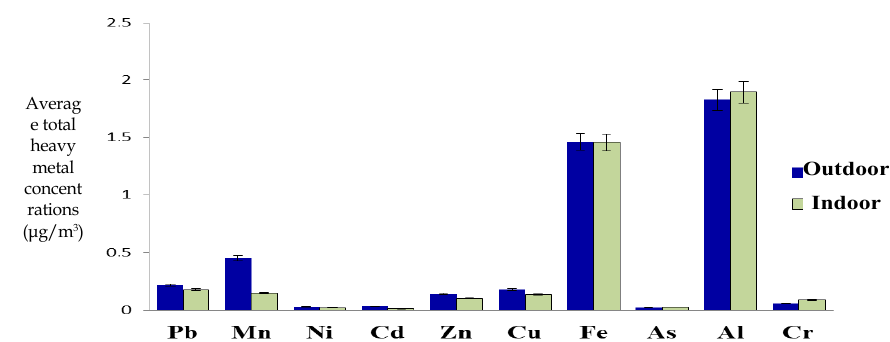
Figure 4. Average heavy metal concentrations in outdoor/indoor spaces of high-traffic districts in Tehran, Winter